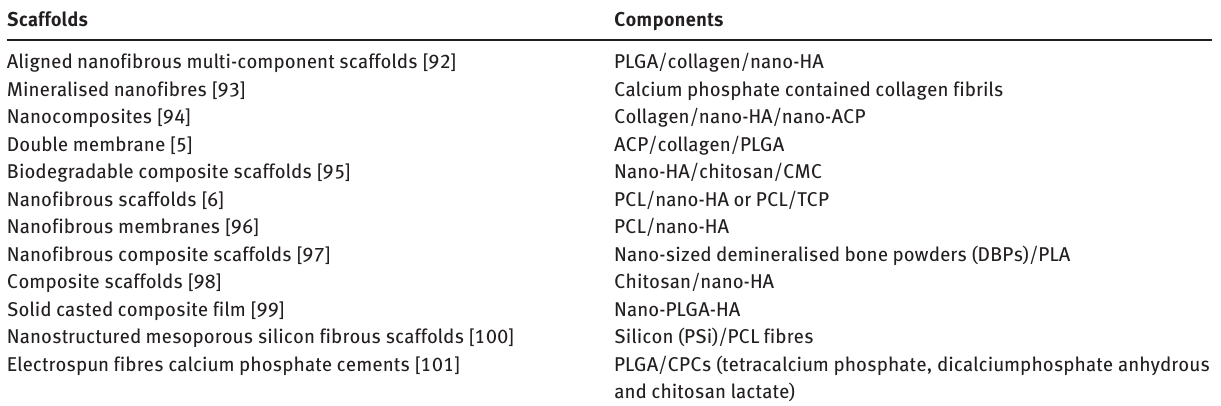
Table 3 Nanocomposites featuring nanobioceramics applied in bone tissue engineering.